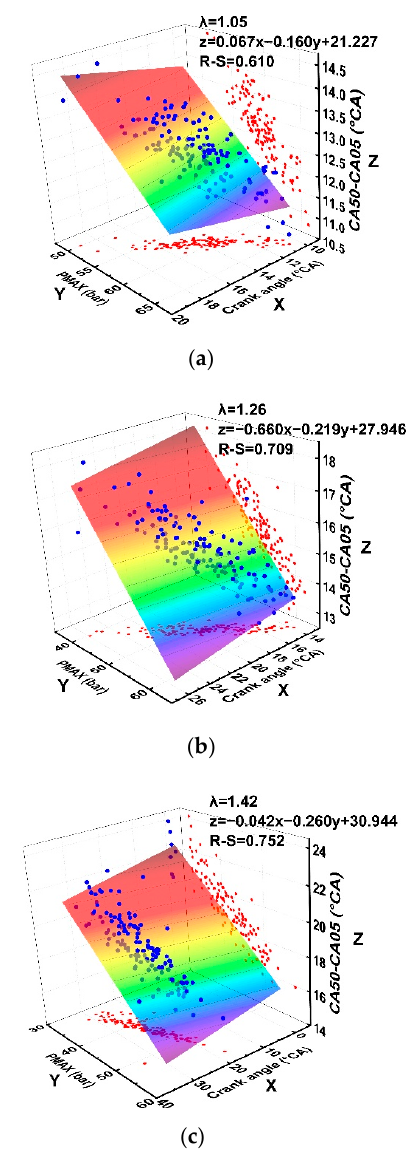
Figure 10. Fitting of CA50-CA05 and PMAX distribution under different λ : ( a ) The fitting of CA50-CA05 and PMAX at λ = 1.05; ( b ) The fitting of CA50-CA05 and PMAX at λ = 1.26; ( c ) The fitting of CA50-CA05 and PMAX at λ = 1.42. Table 9. Fitting parameters of CA50-CA05 and PMAX distribution under different λ .